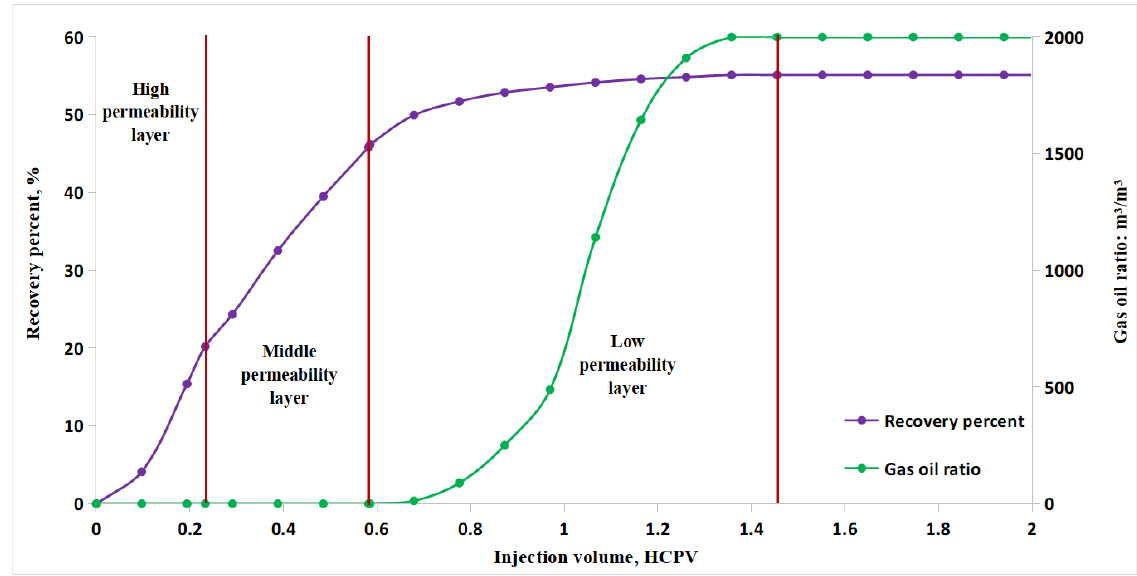
Table 3. Recovery percent of each rhythm layer.